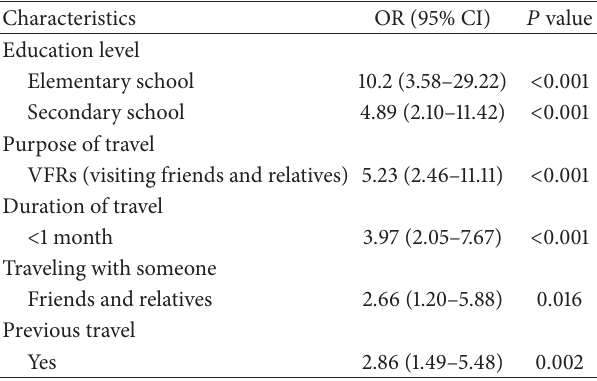
Table 5: Multivariate analysis of factors associated with not pursu- ing health information among travelers to African